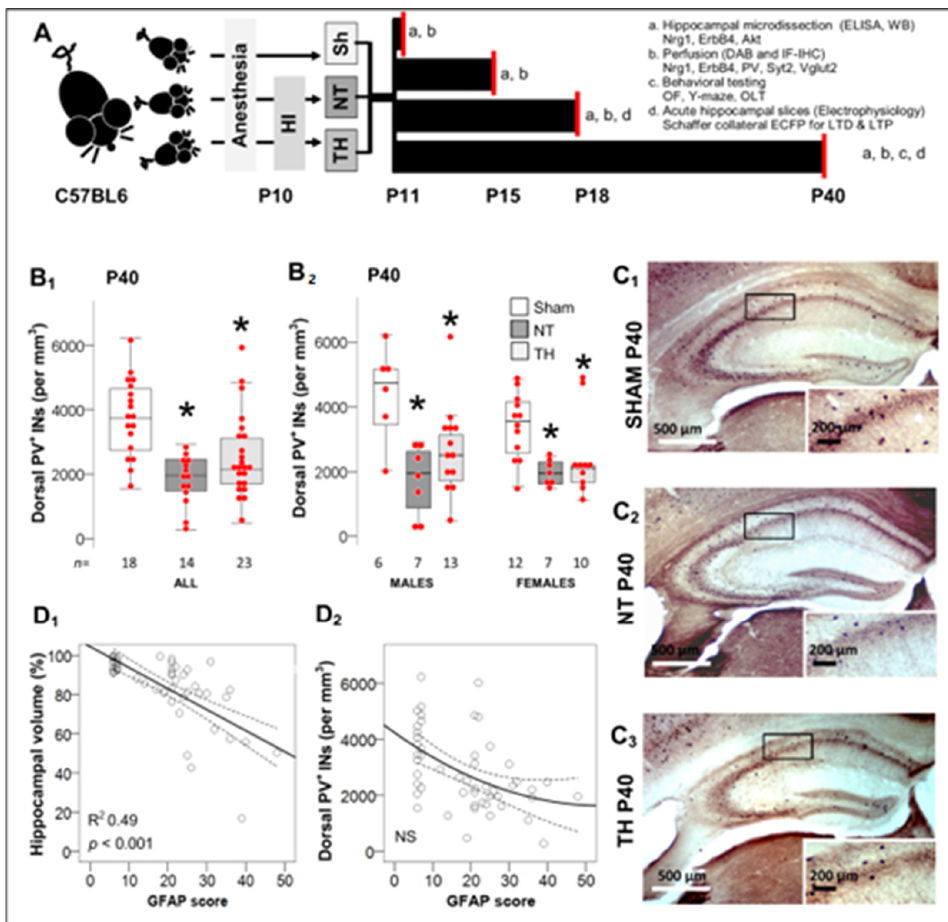
Figure 1. Experimental Design and Deficit of PV + interneurons (INs) 30 days after HI. ( A ) P10 mice were randomized to sham (Sh) or hypoxic-ischemic (HI) injury with normothermia (NT) or therapeutic hypothermia (TH). Mice were aged to P11, P15, P18 or P40 for experimentation as detailed (a, b, c, and d). Neuropathology was only performed if hippocampus was not obliterated. Mice aged to P40 were used for behavioral experiments followed by neuropathology and biochemistry. Electrophysiology experiments (extracellular field potentials, EcFP), were performed in a separate group of mice at P18 and P40. ( B ) At P40, dorsal hippocampus from HI-injured mice had lower number of PV + INs (per mm 3 ) irrespective of treatment with NT or TH ( B 1 ) or sex ( B 2 ). Data are represented as hybrid box and whisker and dot plots, where box is limited by interquartile range (IQR), median is the line inside the box, and whiskers extend to the last datapoint within 1.5 × IQR from median. Outliers are outside the whisker boundaries. *, p < 0.05 (Dunn-Bonferroni post-hoc test for Kruskal Wallis- ANOVA). ( C ) Representative PV DAB-IHC of dorsal hippocampus at P40, ( C 1 ) SHAM P40, ( C 2 ) NT P40, ( C 3 ) TH P40. ( D ) GFAP score of severity of injury [6–8,35] linearly correlated with residual hippocampal volumes [8,9,11], ( D 1 ), but not with the number of PV + INs ( D 2 ) using Spearman Rho correlation.